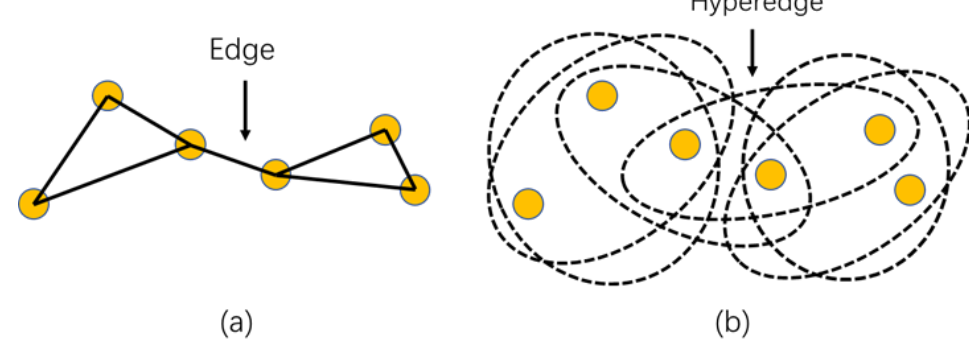
Figure 1. ( a ) Classic graph built by two nearest neighbors. ( b ) Hypergraph built by two nearest neighbors.